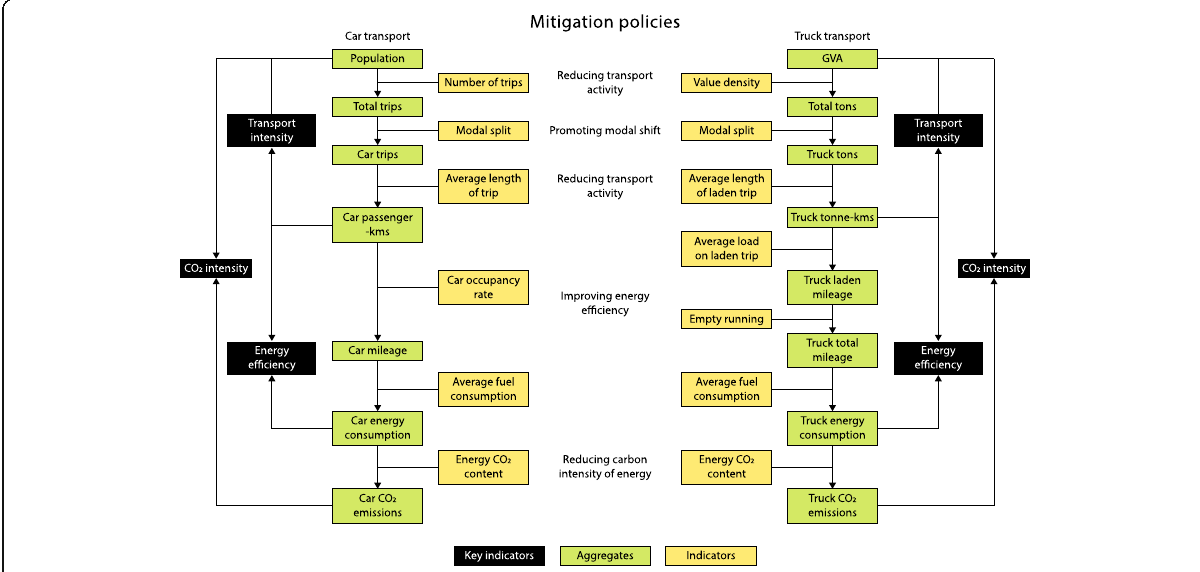
Fig. 2 Framework for analysing the effects of CO 2 mitigation policies on passenger car and freight truck transport. The framework in Figure 2 presents mitigation policies of CO 2 emissions and their connection to different key indicators, aggregates and indicators of CO 2 emissions of car and truck transport. In this study, the framework is used to calculate the CO 2 emissions in different